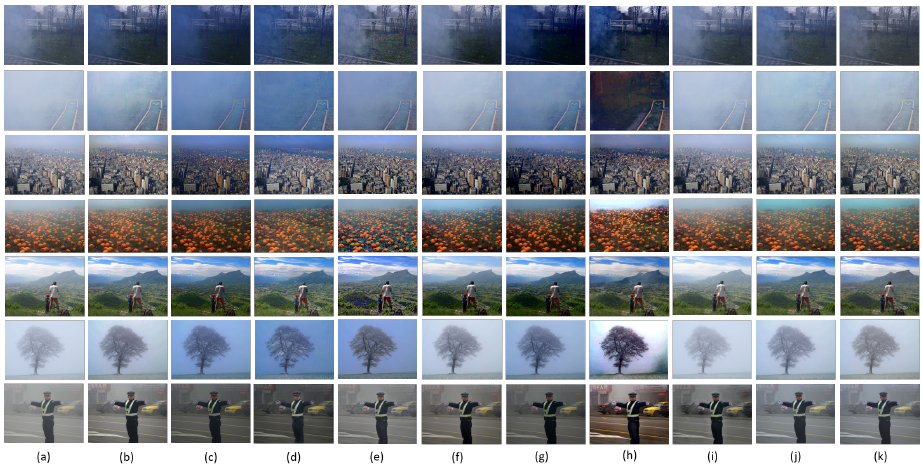
Figure 14. Comparison of fog removal results on real world images: ( a ) input foggy images, ( b ) DCP [6], ( c ) NBPC [15], ( d ) Zhu et al. [12], ( e ) Zhu et al. [22], ( f ) Dehaze-Net [23] ( g ) AOD- Net [26], ( h ) GCA-Net [27], ( i ) FFA-Net [37], ( j ) White fog, and ( k ) Color algorithm.